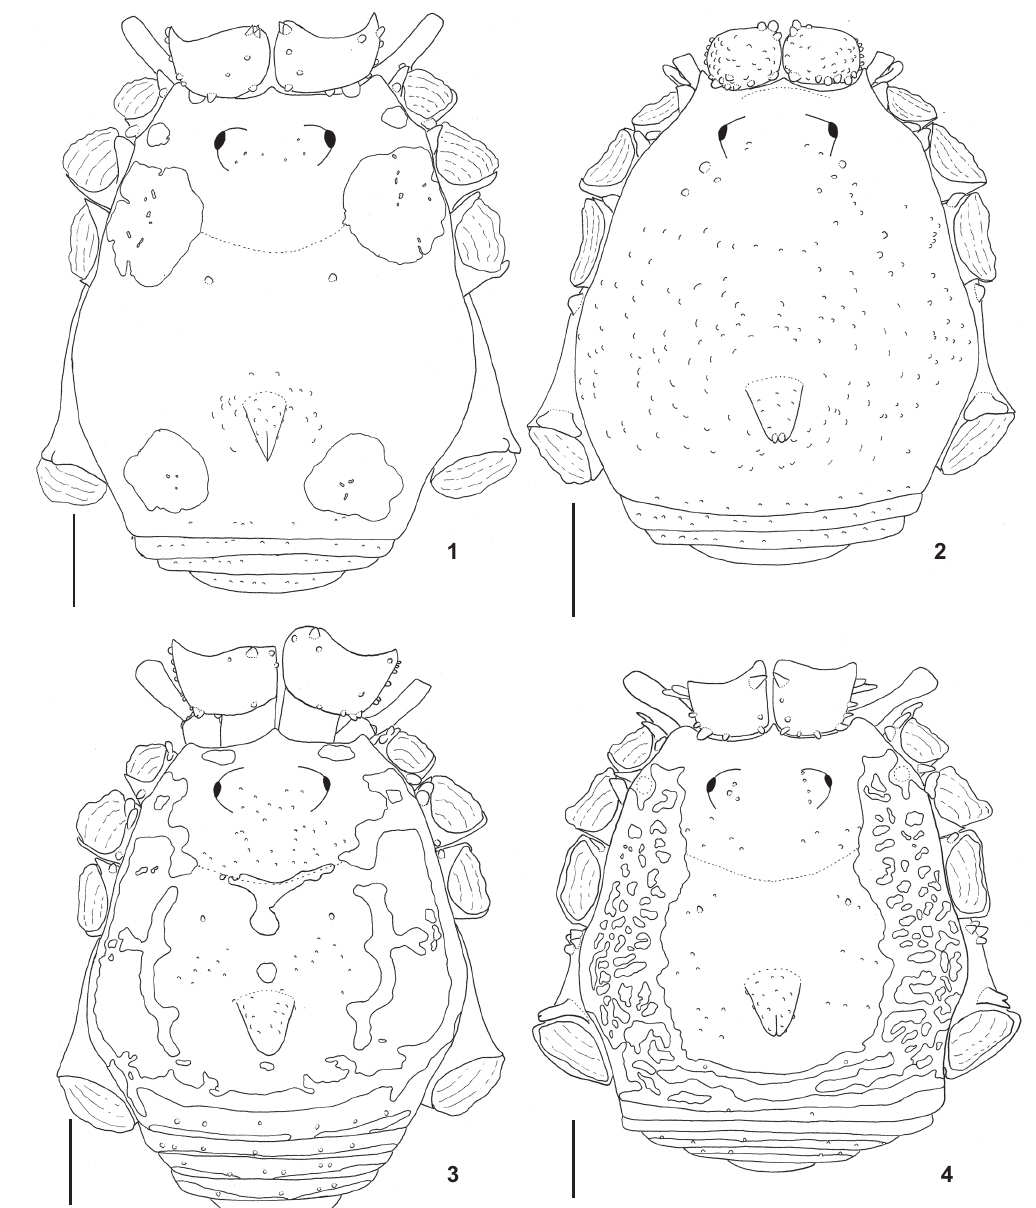
3 Figures 1-4. Habitus of males of Cosmetus in dorsal view: (1) Cosmetus pollera sp. nov. (MIUP); (2) Cosmetus balboa sp. nov. (MIUP); (3) Cosmetus burbayar sp. nov. (MIUP); (4) Cosmetus tamboritos sp. nov. (MIUP). Scale bars = 1 mm. Venter. Coxa I with one row of 14 tubercles and 13 sparse ozopore. Prosoma smooth, ocularium with median depression, small-tuberculate. Area I with one pair of tubercles; area II tubercles. Coxa II, III and IV with sparse setiferous tubercles. Geni- smooth; area III with spine geminate and bifid on its apical tal operculum and stigmatic area with few sparse small tubercles. Chelicera. Dimorphic. Bulla with one large tubercle on third, apex rounded and directed backwards, base more tuber- proximal retrolateral region, eight small retrolateral tubercles, one culated than apex. Posterior margin and free sternites with a row of small tubercles. Anal operculum with setae. tubercle on median region and two-three tubercles on prolateral ZOOLOGIA 32(5): 409–422, October 2015